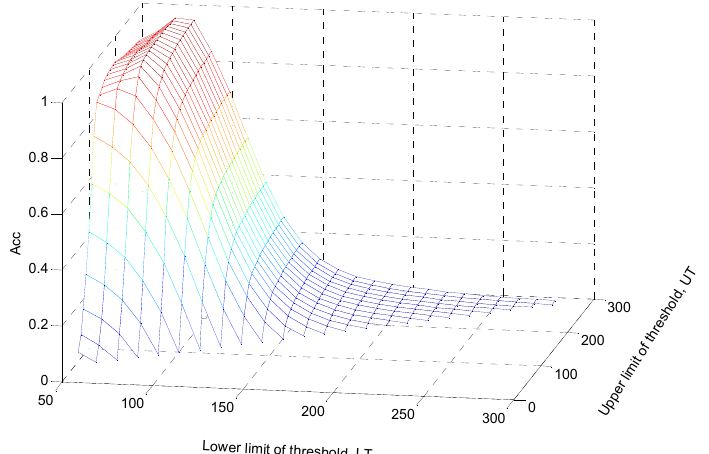
Figure 8. Performance of the Combined Network model under different intensity value threshold ranges. The X axis is the lower limit of the intensity value threshold range, the Y axis is the upper limit of the intensity value threshold range, and the Z axis is the accuracy of our proposed Combined Network for counting rice seedlings.